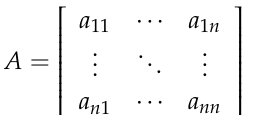
( b ) helper selection, ( c ) cooperative